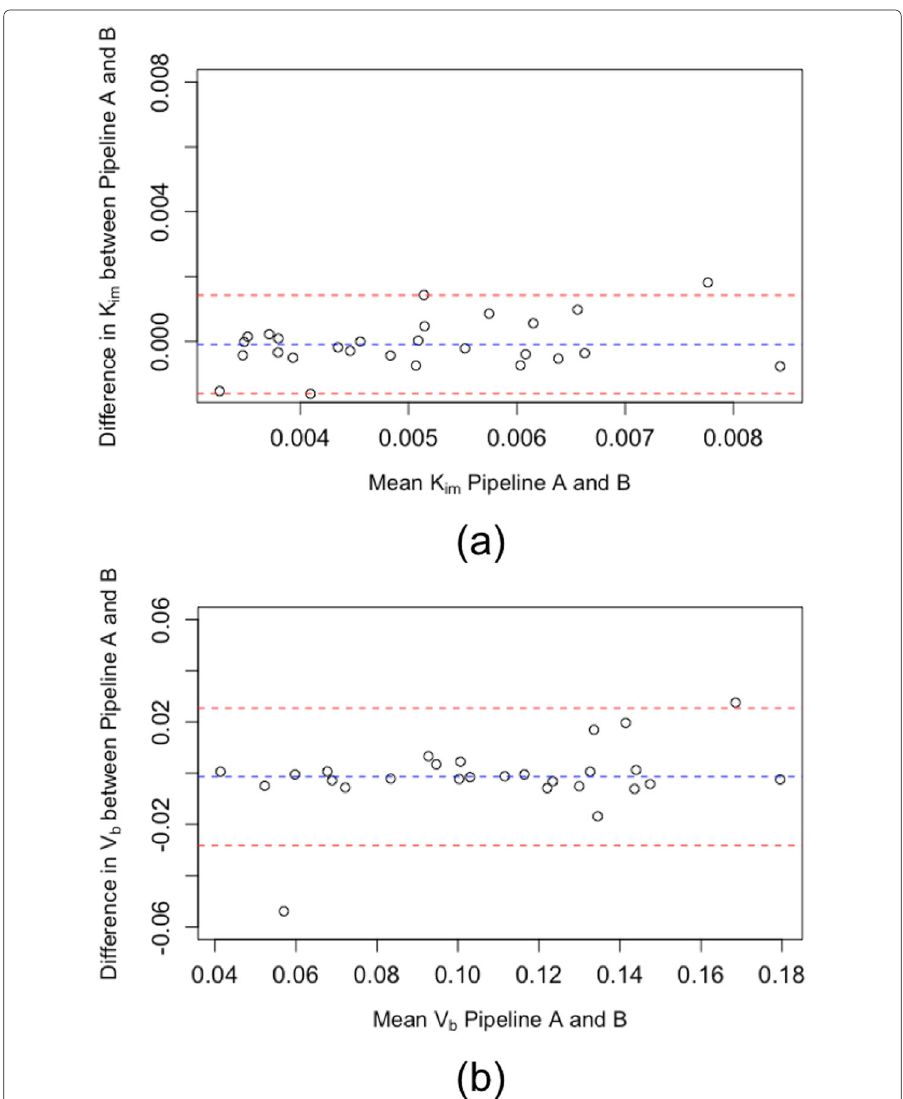
Fig. 6 Bland-Altman plots comparing outcome parameters of a pulmonary compartmental model of 18 F-FDG using two independent analysis pipelines following adjustment of pipeline B. ( a ) K rate constant of FDG. ( b ) V b -the fractional blood volume. This should be compared to the initial results in Fig